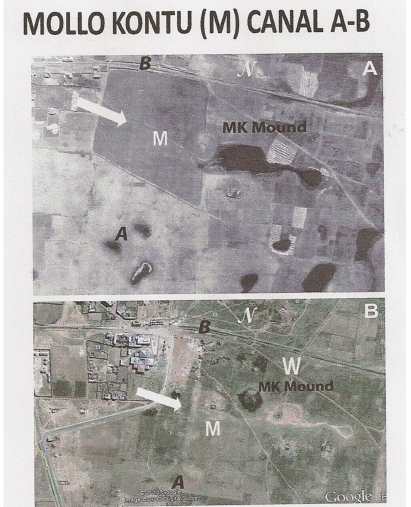
Figure 4. The Mollo Kontu M channel and surface features from Google Earth satellite imagery used to compose Figure